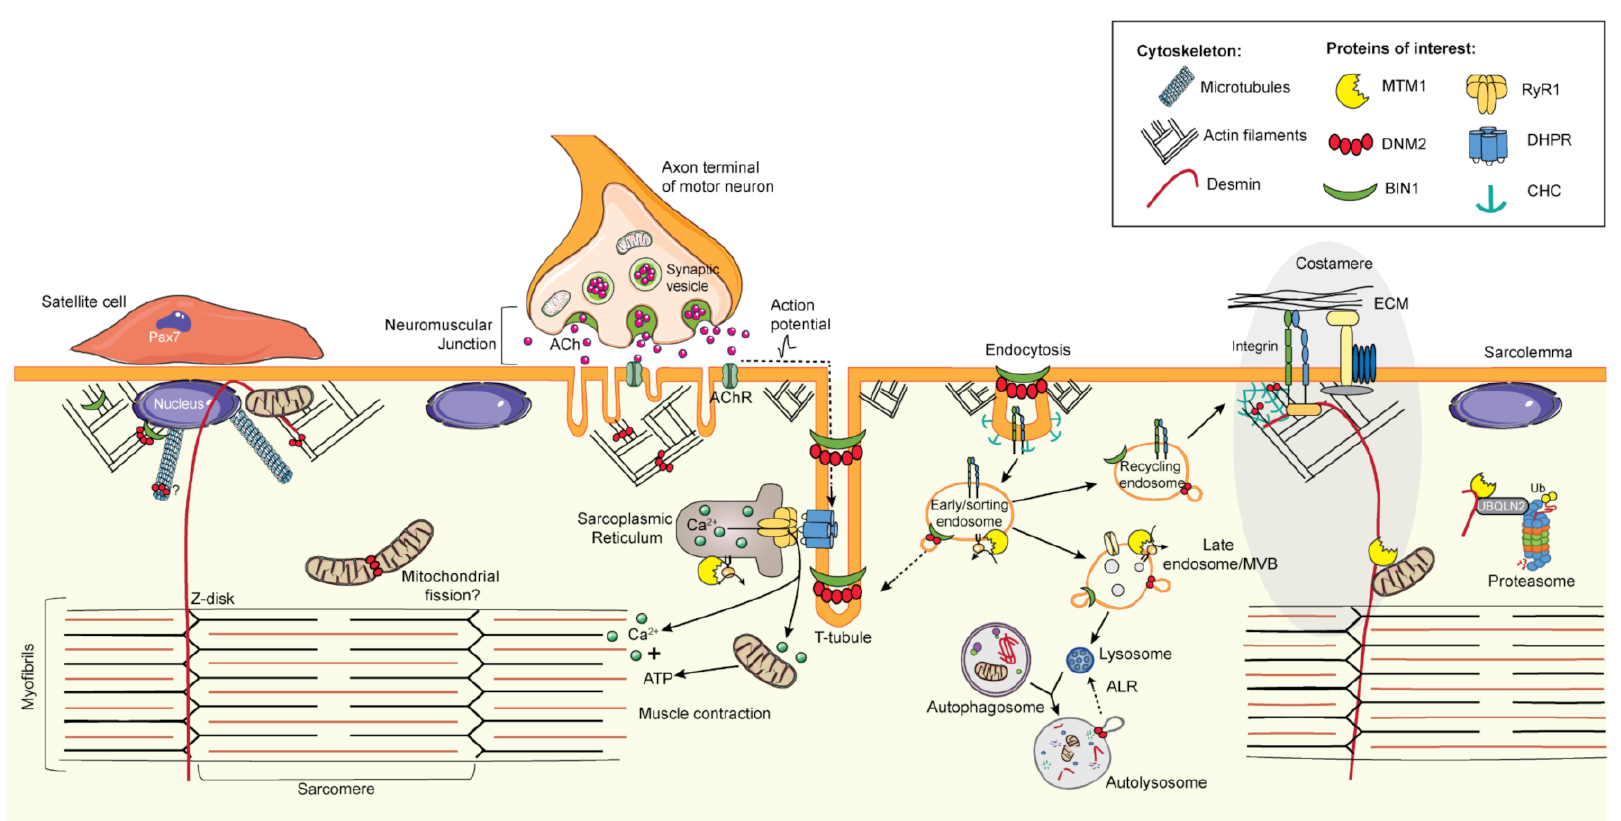
Figure 1. Schematic illustration of localization and functions of MTM1, DNM2, BIN1, and RyR1 in skeletal muscle. ECM (extracellular matrix), ALR (autophagic lysosome reformation), Ub (ubiquitin), Ach (acetylcholine), MVB (multivesicular bodies). The figure uses modified images from Servier Medical Art Commons Attribution 3.0 Unported License (http: //smart.servier.com, accessed on 29 August